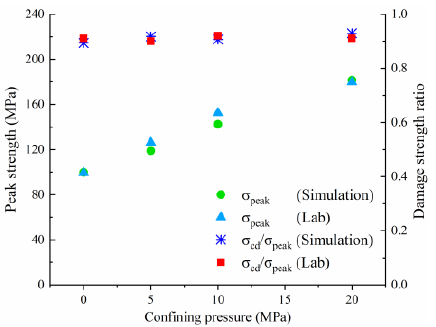
Figure 20. Relationship between peak strength and damage strength ratio under various. Table 6. Comparison of macroscopic rupture between numerical simulation and experiment under different confining pressure conditions. Note: Group A represents macroscopic fracture of numeri- cal simulation; in Group B, blue and red colors represent tensile and shear cracks, respectively; Group C: 1–3, macroscopic fracture and sketch of test sample.